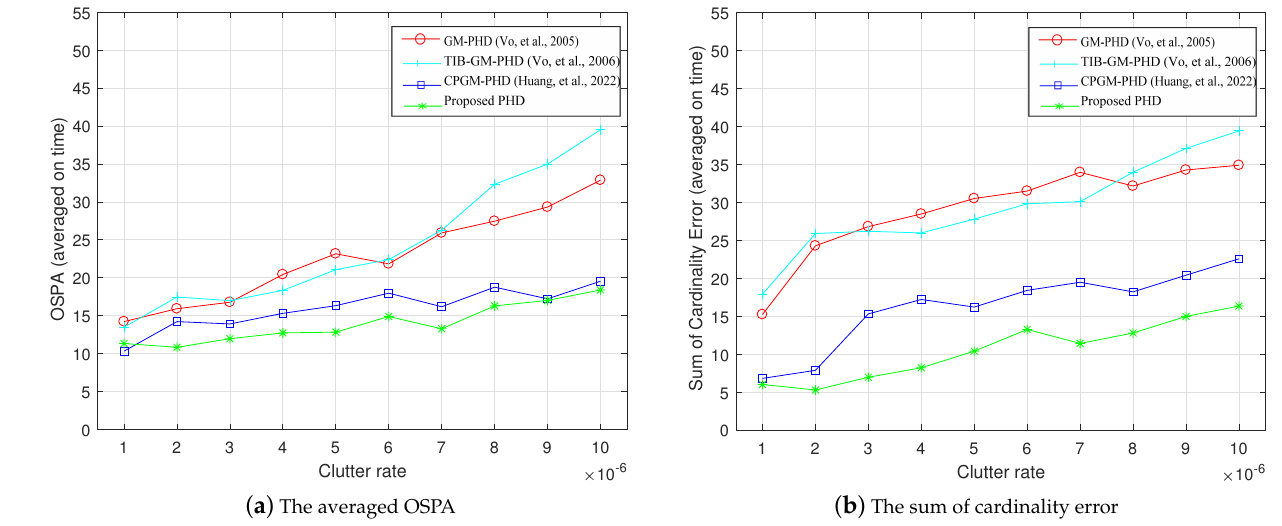
( b ) The sum of cardinality error Figure 14. The averaged OSPA and the sum of cardinality error of GM-PHD, TIB-GM-PHD, CPGM- PHD and Proposed PHD with different clutter rate (The numbers in brackets represent references to various PHD methods).